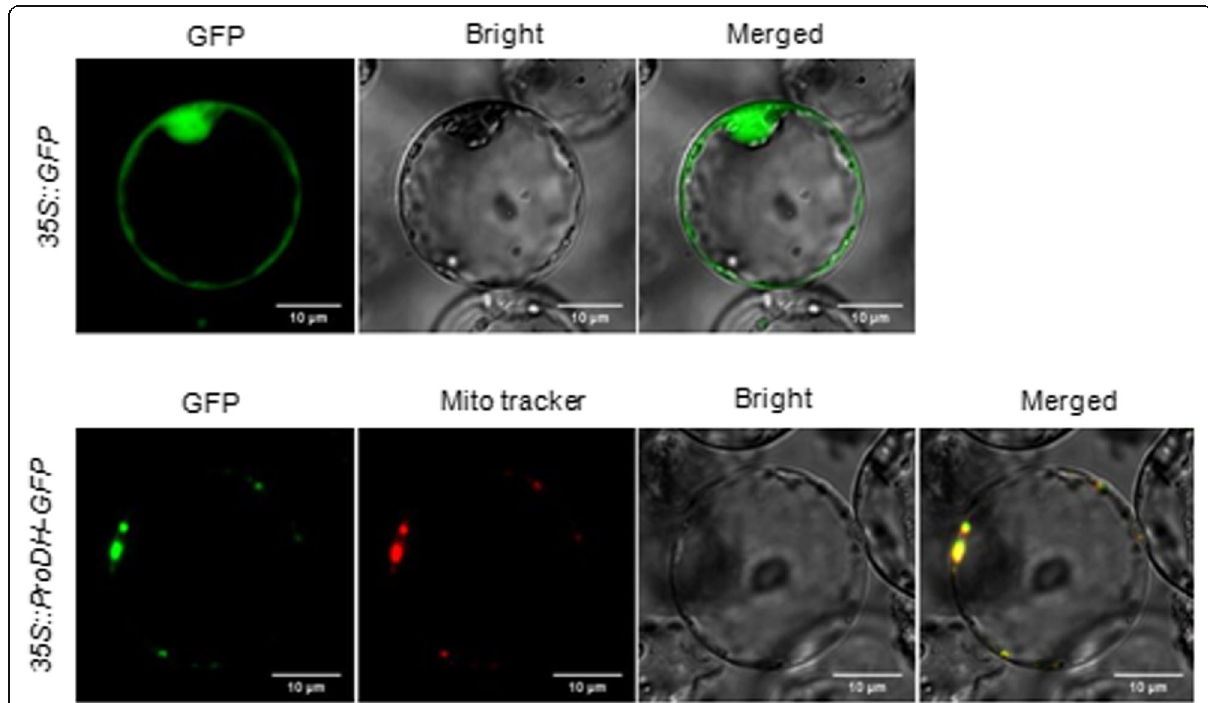
Fig. 2 Subcellular localization of OsProDH. GFP and the OsProDH-GFP fusion were transiently expressed in rice protoplasts. Using mitochondrial tracker, it indicated the OsProDH -GFP fusion protein was specifically expressed in the